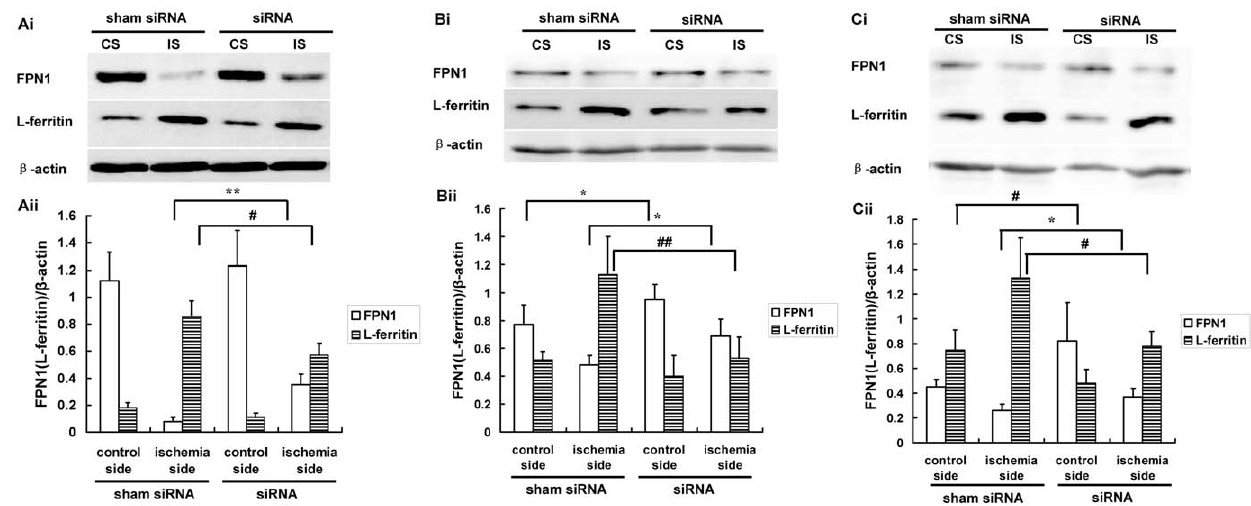
Figure 5. Expression of FPN1 and L-ferritin protein levels in the cerebral cortex, hippocampus and corpus striatum of mouse after hepcidin siRNA injection in the lateral cerebral ventricle. A representative Western blot of the FPN1 and L-ferritin was presented. Quantification of expression of PFN1 and L-ferritin protein in the cerebral cortex (A), hippocampus (B) and corpus striatum (C) of mouse. Expression values were normalized for b -actin. The data were presented as means 6 SEM, n=3. *p , 0.05, **p , 0.01 vs. FPN1 of ischemic side (IS) or control side (CS), # p , 0.05, ## p , 0.01 v.s. L-ferritin of ischemic side (IS) or control side (CS). Sham siRNA (negative control treated group), siRNA (specific hepcidin siRNA treated group).